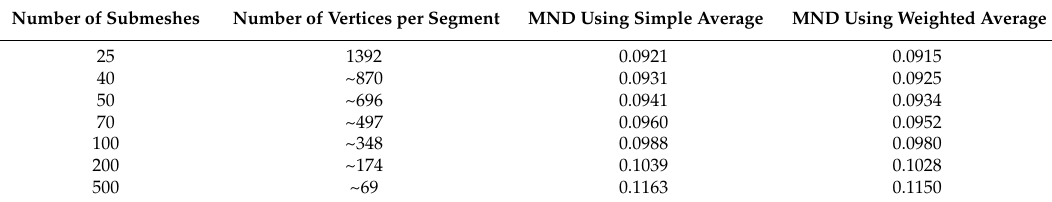
Table 2. Mean Normal Difference using different number of segments (Bunny Model with 34,817 vertices). We also compare the mean normal difference by using normal average and weighted average based on the number of the connected vertices.